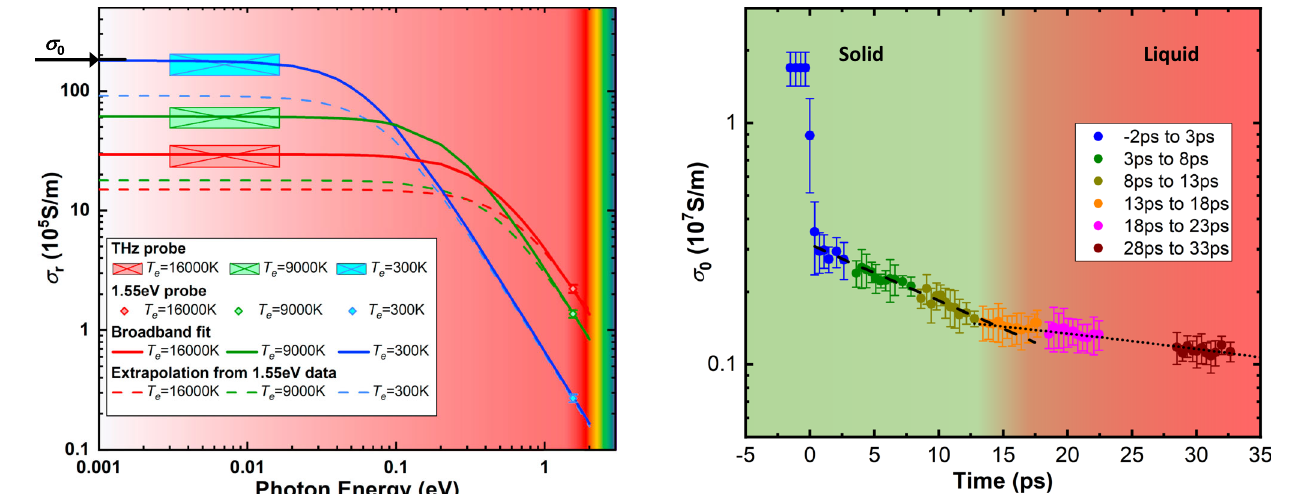
Fig. 3 The electrical conductivity as a function of photon energy for various excitation conditions of solid gold. The broadband electrical conductivity data (real part, σ r ) at electron temperatures of T e = 300 K (blue), 9000 ± 900 K (green) and 16,000 ± 1500 K (red) are indicated by the different colors; the THz conductivity at small photon energies (0.75 – 3.75 THz in frequency, or 3 – 15.5 meV in photon energy) are shown as square blocks that cover the range of frequency components in the THz cycles (horizontal dimension) and uncertainties of the inferred conductivity values (vertical dimension), the optical conductivity at higher photon energies (1.55 eV) from ref. 30 are presented as diamonds, and the DC conductivity at room temperature measured with four-point probe is pointed out by a black arrow. The solid curves represent the Drude model fi t through the high and low frequency data, and the dashed curves represent Drude model extrapolation from the optical conductivity values at 1.55 eV using the Drude model. The conductivity measured with THz radiation agrees well with the DC conductivity from four-point probe measurements, while the extrapolation from optical measurements shows signi fi cant discrepancies.